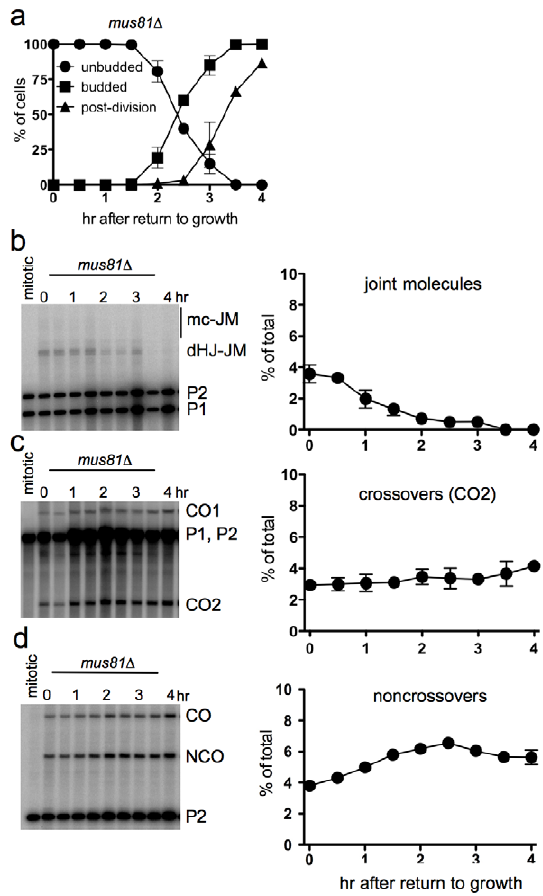
Figure 5. Efficient JM resolution without CO production after RTG in the absence of Mus81. a. Cell cycle progression of ndt80 D mus81 D cells (MJL3389) after RTG. Cell cycle events were scored as in Figure 1. b. JM intermediates. Left: blot of Xmn I digests probed with ARG4 sequences as in Figure 4. Right: total JMs plotted as a percentage of total lane signal. c. COs. Left: blot of Xho I digests probed with ARG4 sequences, as in Figure 4. Right: CO product 2 (CO2), plotted as a percentage of total lane signal. d. NCOs. Left: blots of Xho I /Eco RI digests probed with HIS4 sequences, as in Figure 4. Right: NCO products plotted as a percentage of total lane